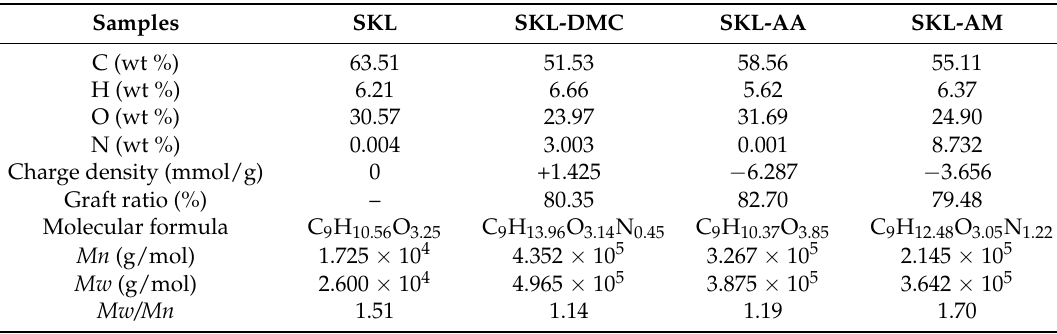
Table 2. Properties of SKL and SKL copolymers.